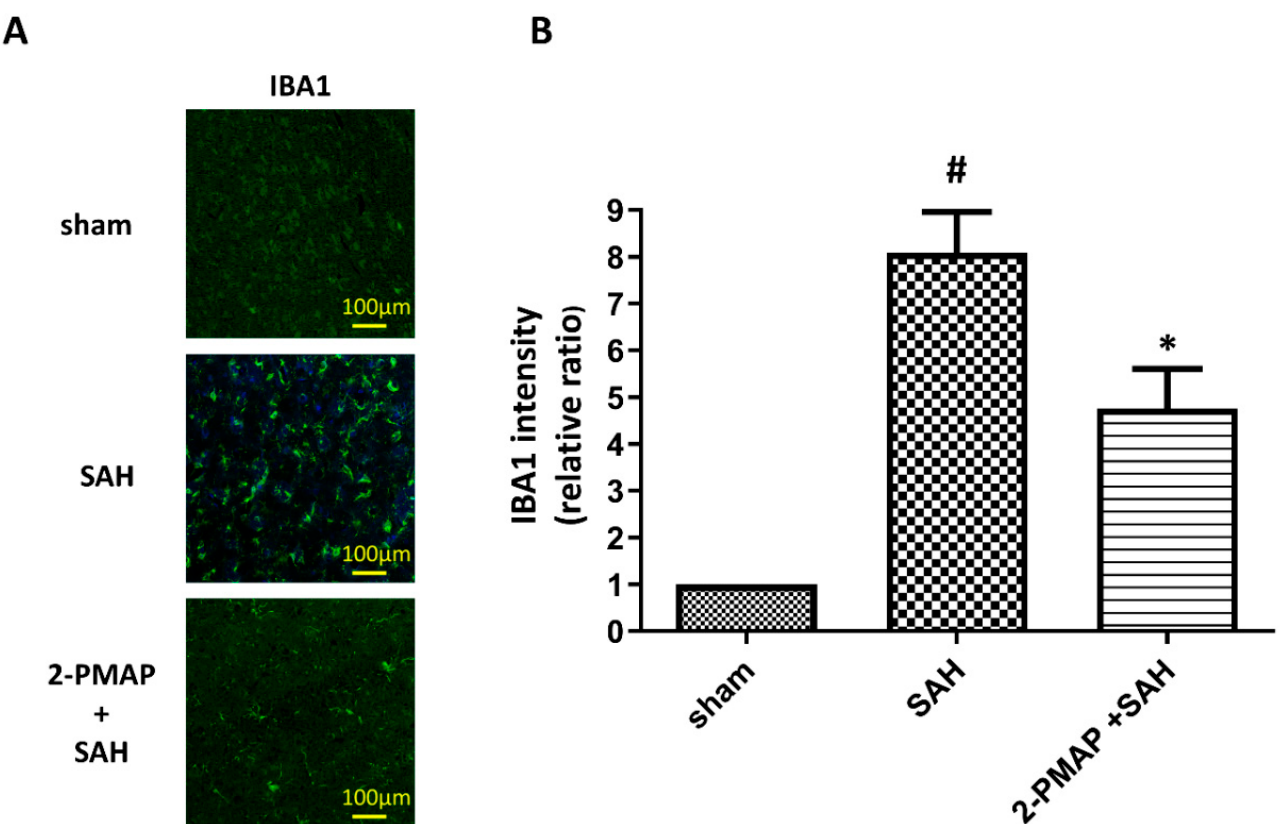
Figure 5. 2-PMAP inhibited microglia activation in SAH rats. Slices of brain tissues were prepared in rats treated with the administration of 2-PMAP, or not, 48 h after the SAH. Immunofluorescence staining showing microglia activation in brain tissues after SAH. ( A ) Representative images for activated microglia in the brain tissues, which show ameboid morphology of IBA1-positive microglia. Scale bars: 100 µ m. ( B ) Relative fluorescence intensity of IBA-1. Data are shown as mean ± SD ( n = 6 for each group); *, p < 0.05, significantly different from the SAH group. #, p < 0.05, significantly different from the sham group.